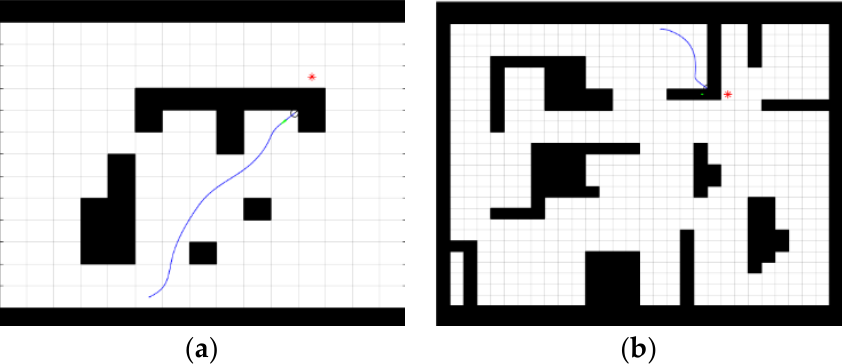
Figure 10. Traditional dynamic window method-based planning path. ( a ) 15 ∗ 15 map, ( b ) 30 ∗ 30 map.